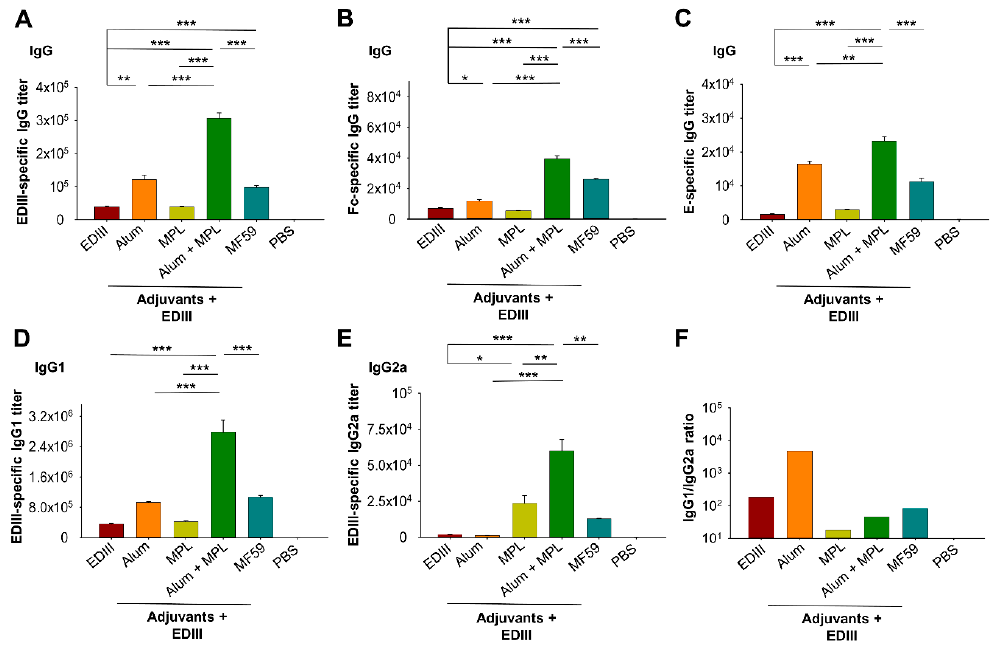
Figure 2. Detection of specific antibodies in mouse sera. ZIKV EDIII-, E-, or Fc of human IgG1 (hFc)-specific antibody levels were determined by ELISA using sera collected at seven days following the second dose of ZIKV EDIII. ( A ) ZIKV EDIII-specific IgG; ( B ) hFc-specific IgG; ( C ) ZIKV E-specific IgG; ( D ) ZIKV EDIII-specific IgG1; ( E ) ZIKV EDIII-specific IgG2a antibodies. ( F ) The IgG1/IgG2a ratio for EDIII without or with each adjuvant, or adjuvant combination. ELISA plates were coated with ZIKV EDIII containing a C-terminal hFc or full-length E protein containing a His 6 tag. Middle East respiratory syndrome coronavirus (MERS-CoV) receptor-binding domain (RBD)-Fc protein (i.e., MERS-CoV RBD containing a C-terminal hFc) was used to test hFc-specific IgG antibodies. Adjuvants are indicated in all the figures. PBS represents the background level of specific antibodies. The antibody titers shown are the endpoint dilution where a positive signal was detected. Data are shown as the mean ± the standard error of the mean (s.e.m) ( n = 5). Significant differences (*: p < 0.05; **: p < 0.01; ***: p < 0.001) among different groups are shown.